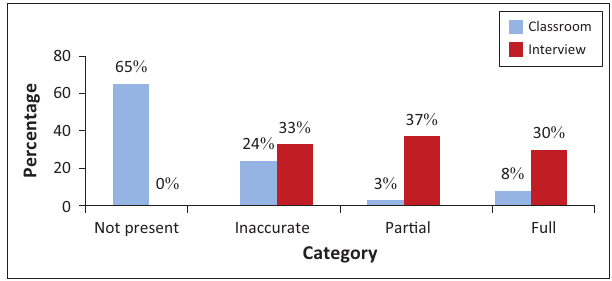
FIGURE 4: Conceptual explanations in relation to the error (averages across all rounds).